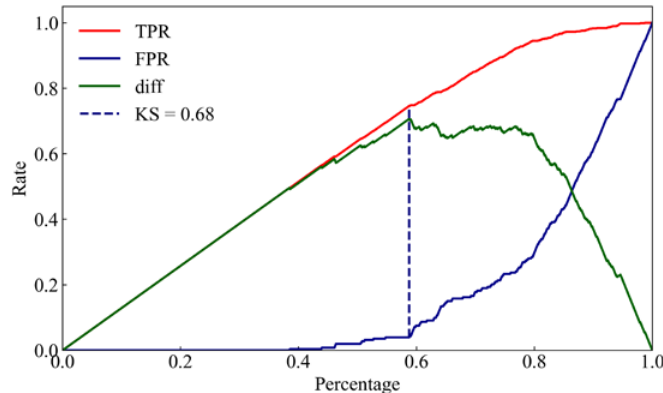
Figure 8. KS curve. Figure 8. KS